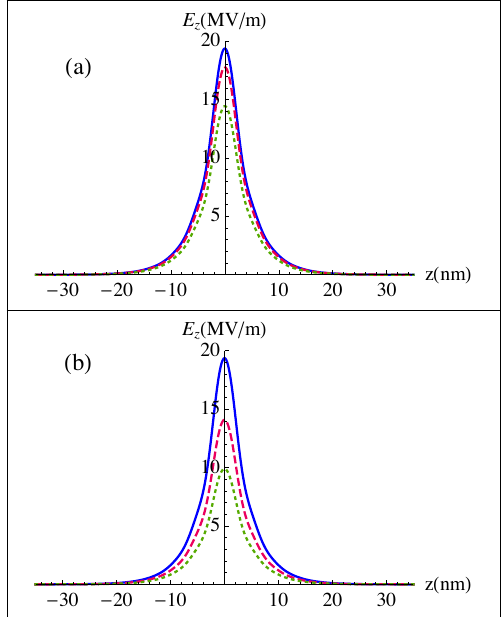
Figure 5. Confined plasmonic fields near the GNDs layer with a mobility of 20,000 cm 2 /Vs excited by a 10 fs-sech pulse of λ 0 = 30 µ m, in the presence of metallic contact, i.e., an Ag NPs lattice of width W = 0.25 λ 0 at x / W = 0.45 with δ GNDs = 100 − δ AgNPs = 150. The two lattices are embedded in a dielectric of (cid:101) = 3. The thickness and doping level of GNDs ar: ( a ) t = 0.34 nm, E F = 1 eV (solid), E F = 0.7 eV (dashed) and E F = 0.4 eV (dotted). ( b ) E F = 1 eV, t = 0.34 nm (solid), t = 0.55 nm (dashed), t = 0.6 nm